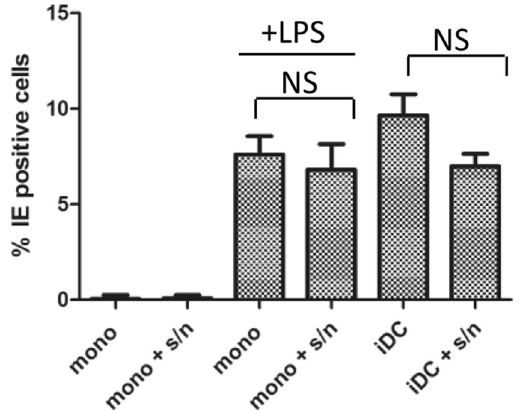
Figure 5. The supernatant of latently infected monocytes does not prevent LPS mediated effects on uninfected monocytes. To generate a latent secretome monocytes were infected with HCMV and cell free conditioned media harvested at 7dpi (s/n). Fresh monocytes were either incubated with normal (mono) or conditioned (mock + s/n) media for 48 hours. A fraction of the cells from both conditions were then further stimulated with (500 ng/ml LPS for 24 hours). Alternatively, uninfected monocytes were differentiated to permissive dendritic cells and incubated with normal media (iDC) or supernatant from latently infected monocytes (iDC + s/n) again for 48 hours. All cells were then infected with Merlin 2 days post incubation with mock or conditioned media and stained for IE protein expression 24 hpi. Nuclei were counter-stained with DAPI and infection rate calculated n = 3. NS = non-significant difference when comparing infection rates between mock and conditioned media treated